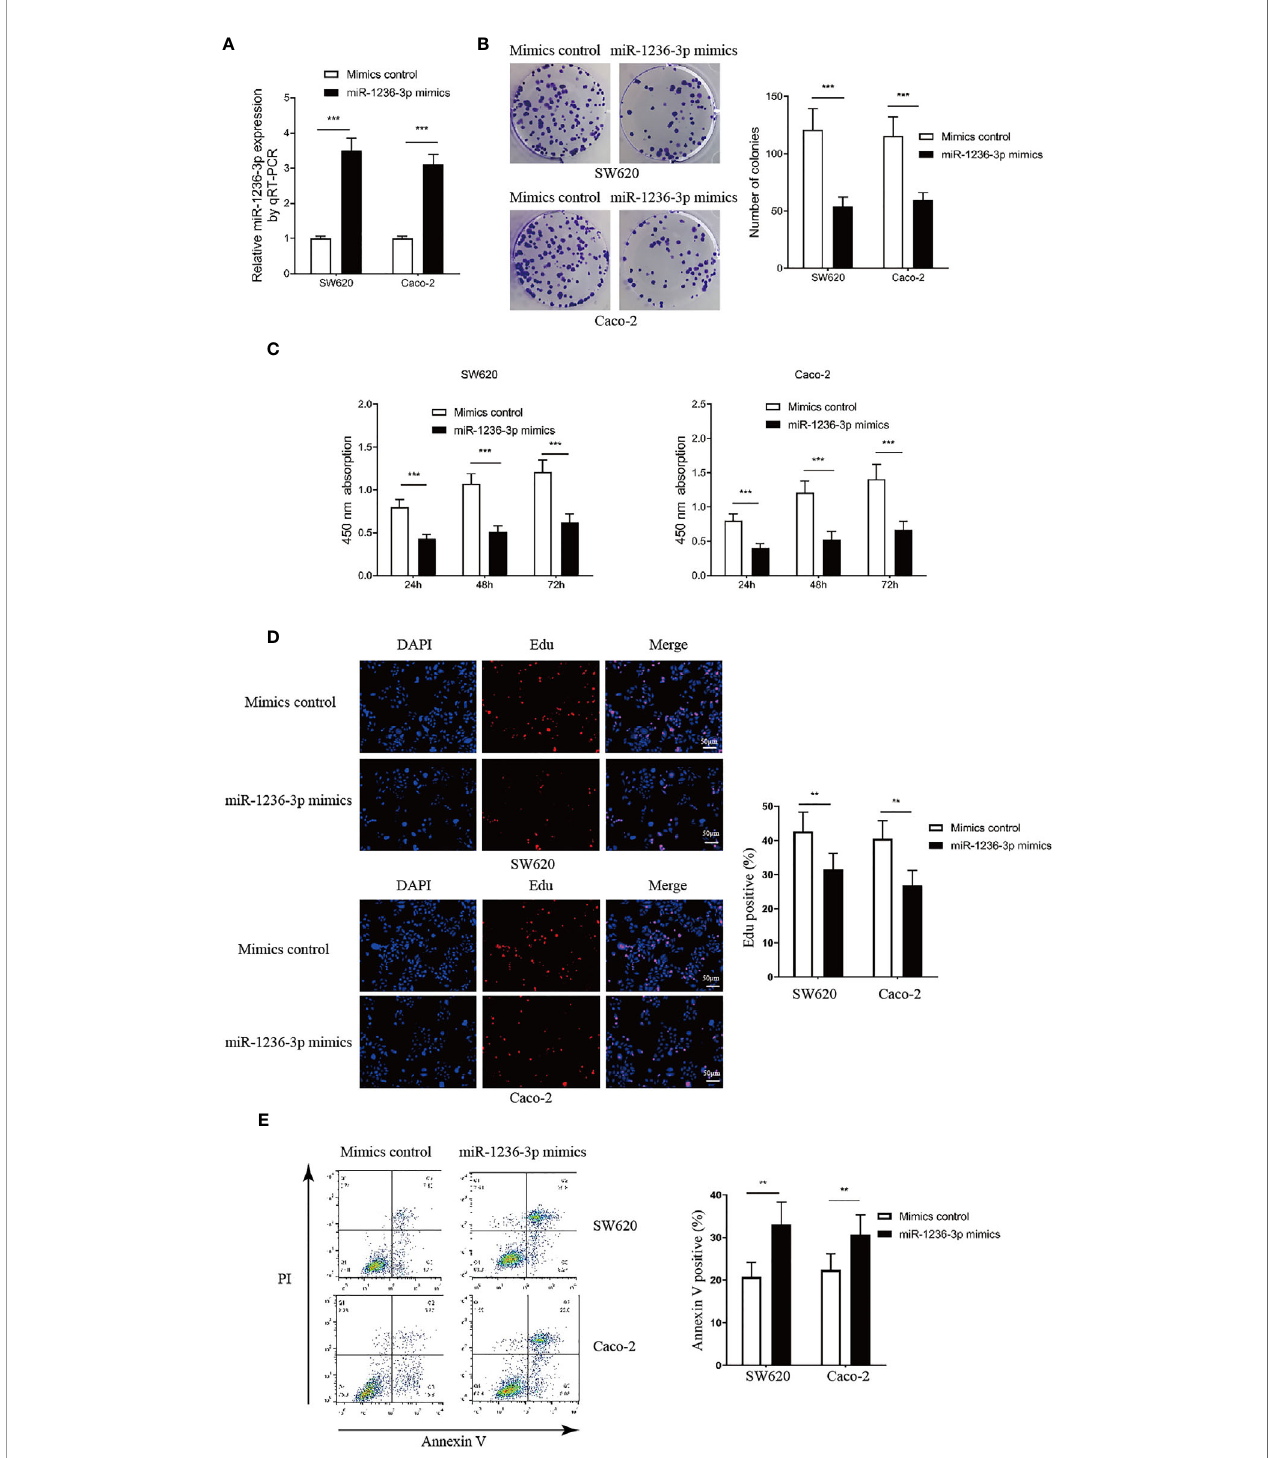
FIGURE 2 | MiR-1236-3p inhibited colon cancer proliferation and promoted apoptosis in vitro . (A) Relative miR-1236-3p expression by qRT-PCR after transfecting with miR-1236-3p mimic and mimic control in SW620 and Caco-2 cell lines for 48h. (B) Colony formation assays. (C) Cell proliferation by the CCK-8 assay at 450 nm at 24, 48, and 72 h after cell seeding. (D) EdU assay by immuno fl uorescence analysis. (E) Cell apoptosis evaluation by FCM analysis. FCM, fl ow cytometry; CCK-8, Cell proliferation by Cell Counting Kpit-8; qRT-PCR, quantitative reverse transcription – polymerase chain reaction; Error bars represent the mean ± s.e.m.; **P < 0.01, ***P < 0.001 by Student ’ s t-test, six replicates per group for each